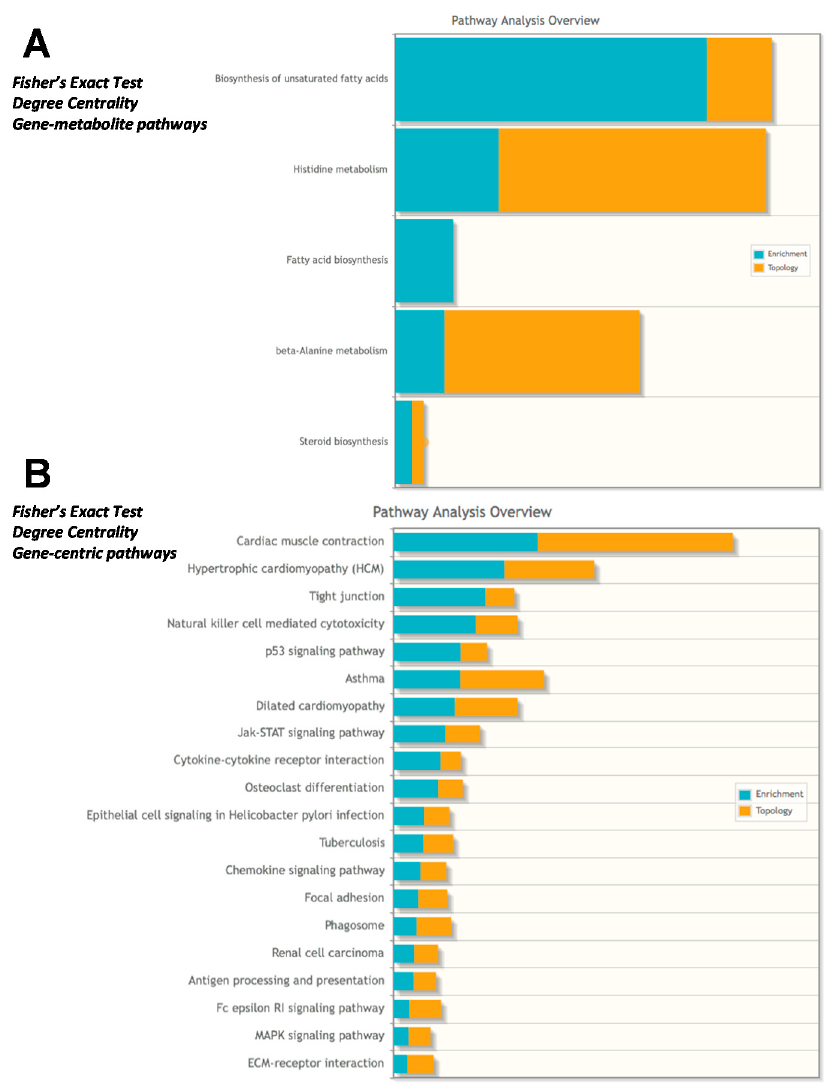
Figure 8. Integrated metabolomics analysis using recently published microarray analysis. Fisher’s exact test using degree centrality was performed using ( A) Gene-metabolite pathways or ( B) Gene-centric pathways in Metaboanalyst. GRMD significant metabolites ( t -test, VIP >2.0 listed in Table S2) and mRNA >1.9 or < − 1.3 fold from GRMD muscle (downloaded from GEO, as published in Pediatr Res . 2016 Apr;79(4):629-36) and listed in Table S3 with fold change calculations) were included in the Metaboanalyst integrated analysis.